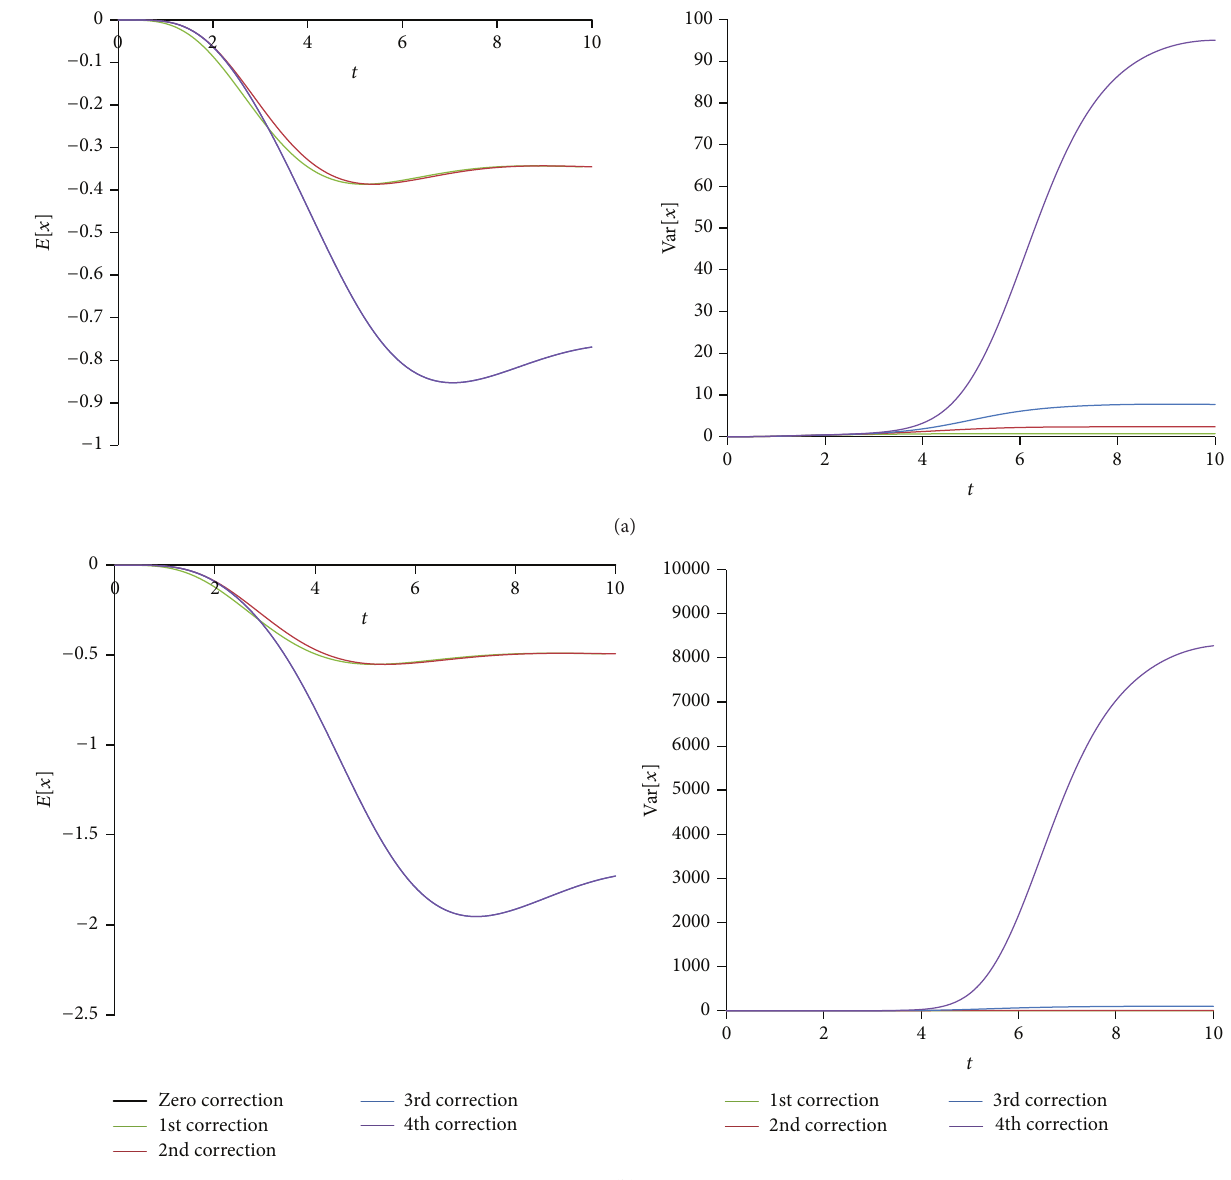
Figure 11: The third-order response mean and variance for (a) 𝜀 = 0.7 and (b) 𝜀 = 1.0